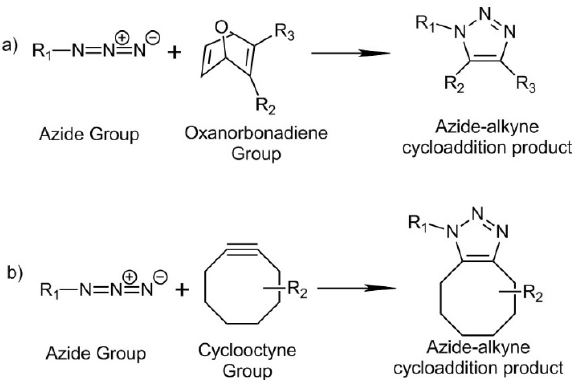
Figure 6. Strain-promoted azide–alkyne cycloaddition (SPAAC) reaction between azide and ( a ) oxanorbonadiene and ( b ) cyclooctune groups.